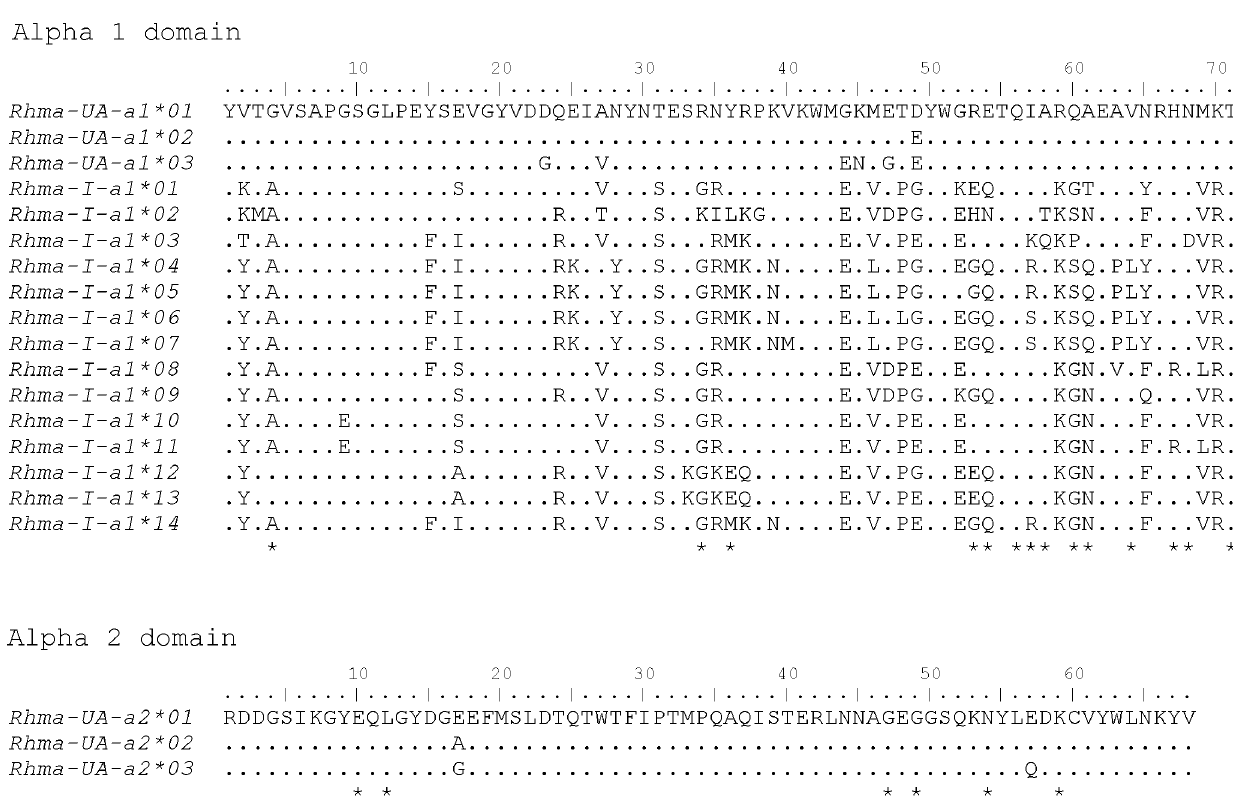
Figure 3. Amino acid alignment of MHC class I alpha 1 domain and alpha 2 domain variants. Putative peptide binding sites are indicated with * under each alignment.